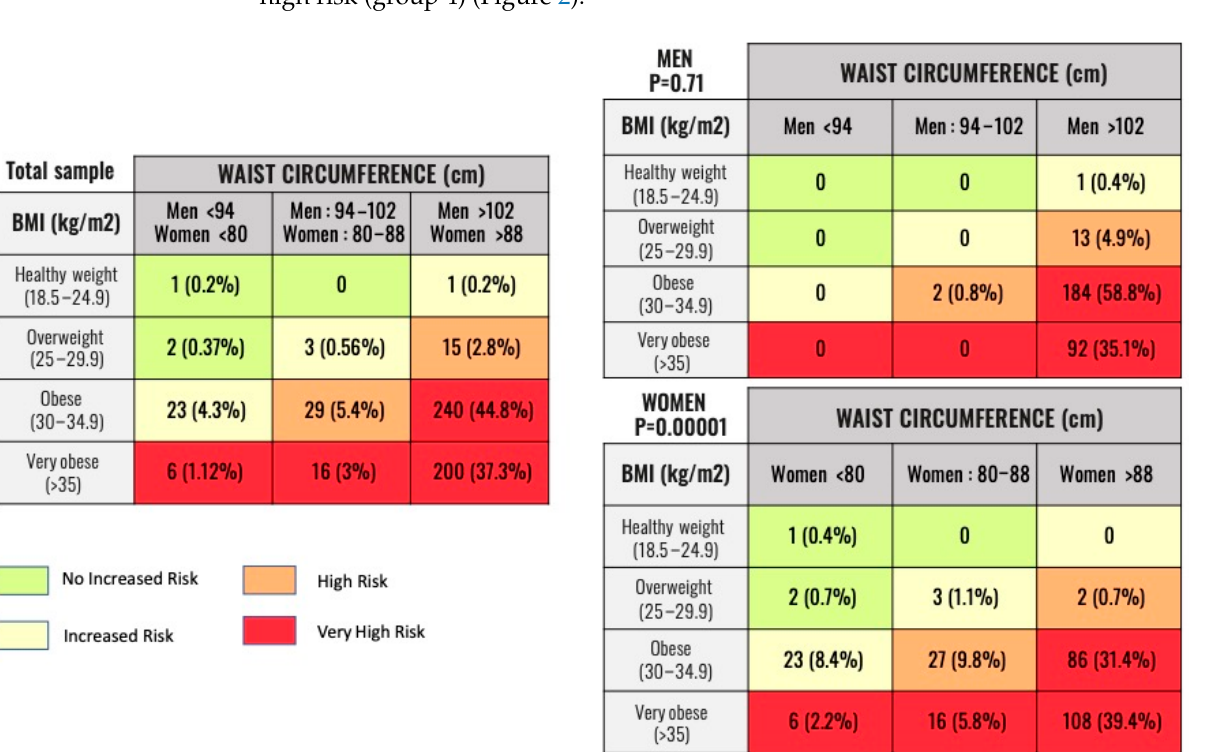
Figure 1. Patient inclusion flowchart. BMI: Body Mass Index; KNN: k-nearest neighbors (KNN) algorithm; WC: Waist Circumference.